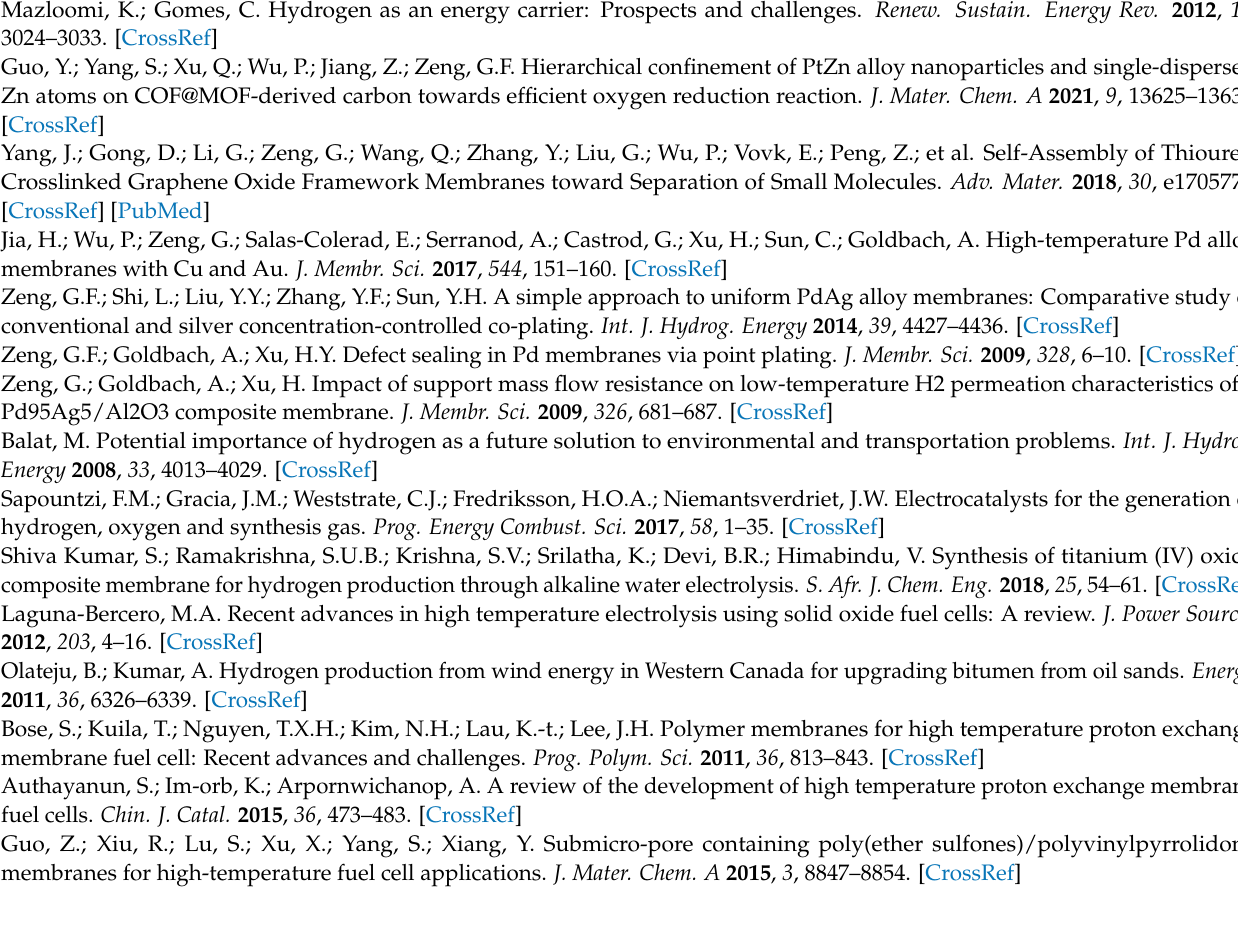
Figure S3: SEM cross-sectional view of PVC membrane; Figure S4: SEM cross-sectional view of P4VP membrane; Figure S5: SEM cross-sectional view of PVC-P4VP membrane; Figure S6: SEM cross-sectional view of PVC-P4VP/PA membrane; Figure S7: Nyquist plots of (a) PVC-P4VP(1:1)/PA, (b) PVC-P4VP (1:1.5)/PA, (c) PVC-P4VP(1:2)/PA at 100–180 ◦ C; Figure S8: Temperature dependence of conductivity with PVC-P4VP membranes; Figure S9: Stability of proton conductivity of PVC- P4VP(1:2)/PA membrane at 140 ◦ C; Table S1: The thickness and surface area of membranes; Table S2: Stress-strain parameter for PVC, P4VP, PVC-P4VP(1/X) and PVC-P4VP(1/X)/PA